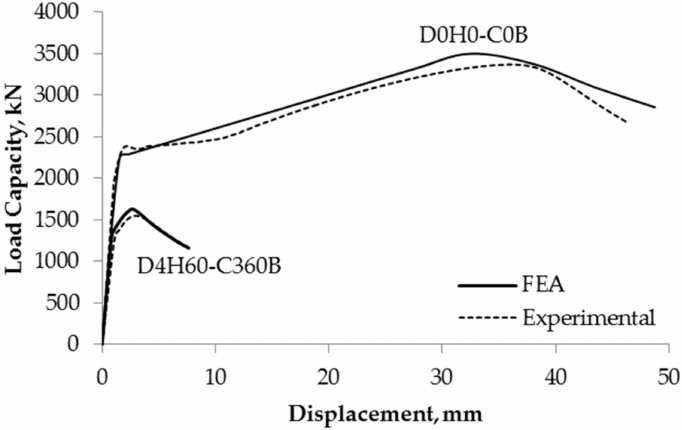
Figure 10. Comparison of experimental results and numerical results of non-corroded and corroded